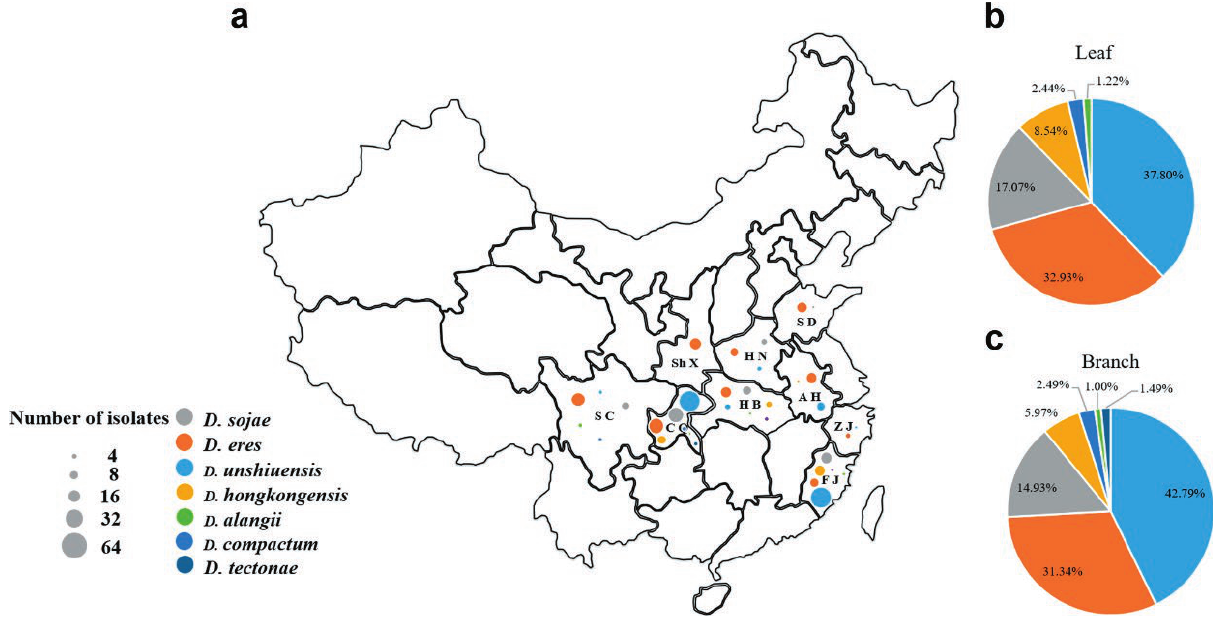
Figure 9. Sample collections of kiwifruit shoot blight and leaf spot diseases, and distribution of Diaporthe species in China. a, numbers and species of different Diaporthe species from kiwifruit plants. Each coloured circle represents one fungus species, and the size of the circle indicates the number of isolates. Abbreviations indicate provinces or regions of Anhui (AH), Chongqing (CQ), Henan (HN), Hubei (HB), Fujian (FJ), Shandong (SD), Shanxi (ShX), Sichuan (SC) and Zhejiang (ZJ). b, and c, isolation rates (%) of different Diaporthe spp. from kiwifruit leaf or branch